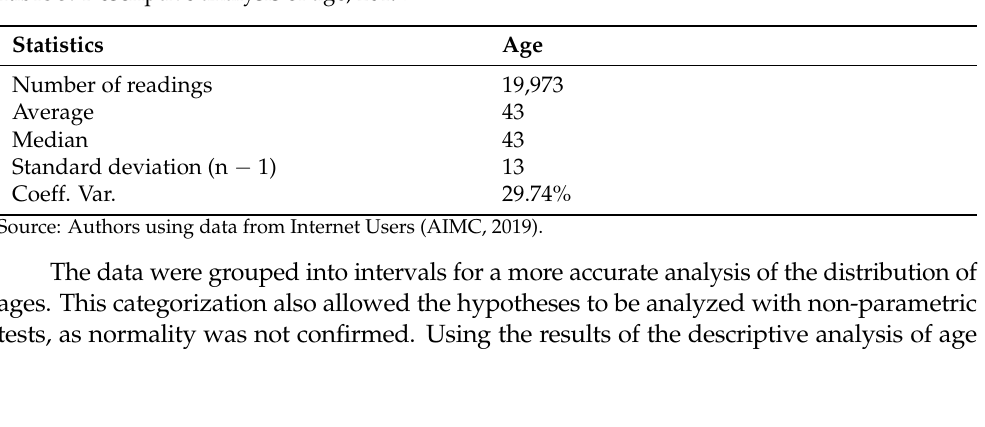
Table 3. Descriptive analysis of age,